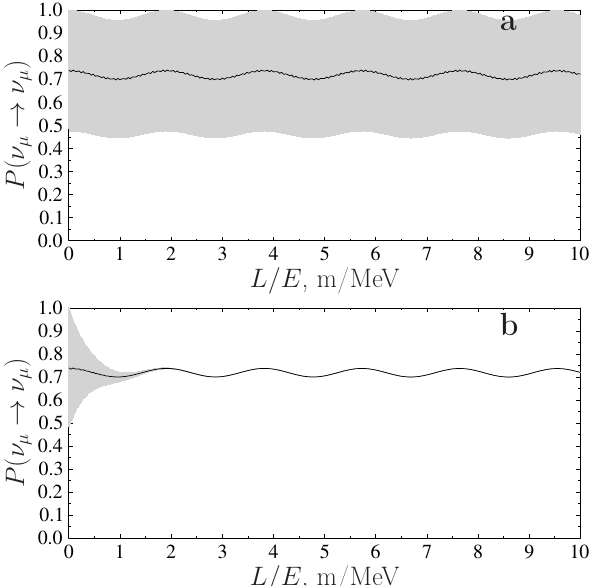
Figure 2. The survival probabilities for ν µ depending on the ratio of the distance L from the source to the neutrino energy E in the beams of ν µ for stable ( a ) and decaying ( b ) sterile neutrinos with masses m 4 = 1.14 eV, m 5 = 7 keV and m 6 = 1 MeV and with decay widths Γ 4 = 10 − 14 eV, Γ 5 = 10 − 7 eV and Γ = 10 − 5 eV. For matrix U = 0.087 and η = 15 ◦ ( η = 0 and η = 6 mix , (cid:101) 2 3 4